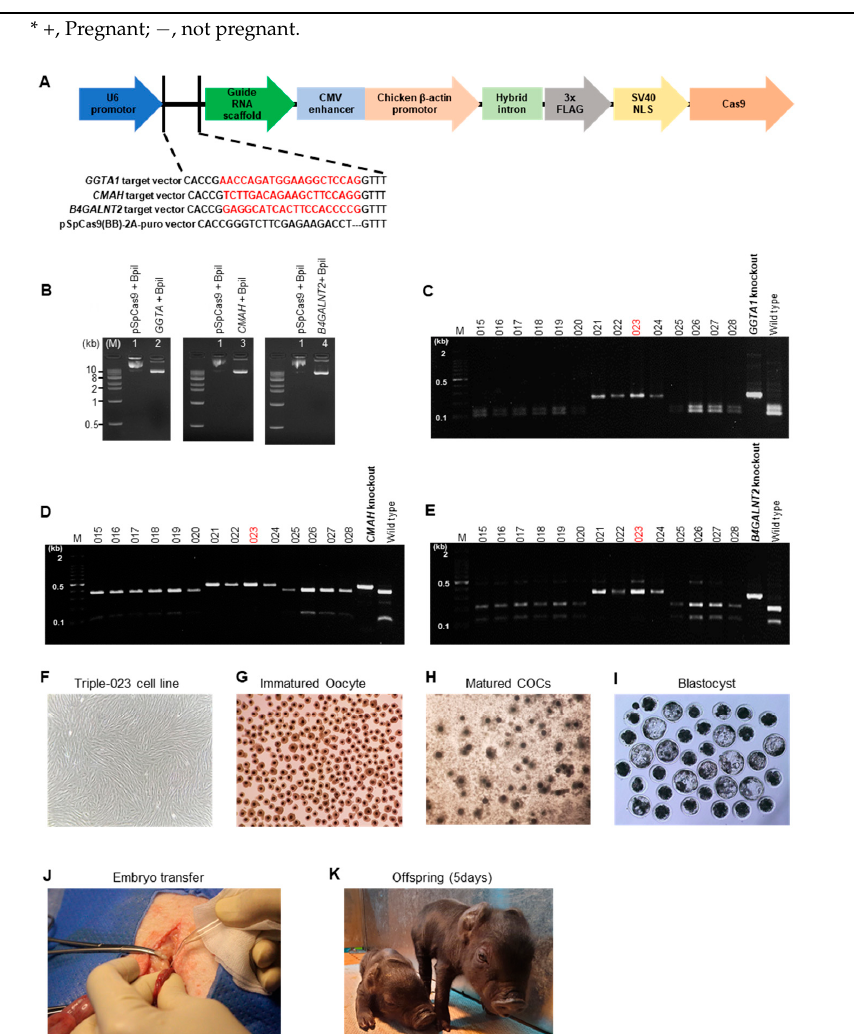
Figure 2. Procedure for triple ‐ knockout development. ( A ) Schematic representation of designing gRNA (vector schematic diagram including Guide RNA); ( B ) preparation of vector expressing Cas9 and gRNA targeting triple gene; M: 1 kb DNA ladder, Lane 1: pSpCas9(BB) ‐ 2A ‐ Puro vector treated with BpiI, Lane 2: GGTA1 target vector treated with BpiI, Lane 3: CMAH target vector treated with BpiI, Lane 4: B4GALNT2 target vector treated with BpiI; ( C – E ) RFLP analysis of GGTA1 , CMAH , and B4GALNT2 , where the PCR product from each single cell was treated with BsrI; ( F ) constructed